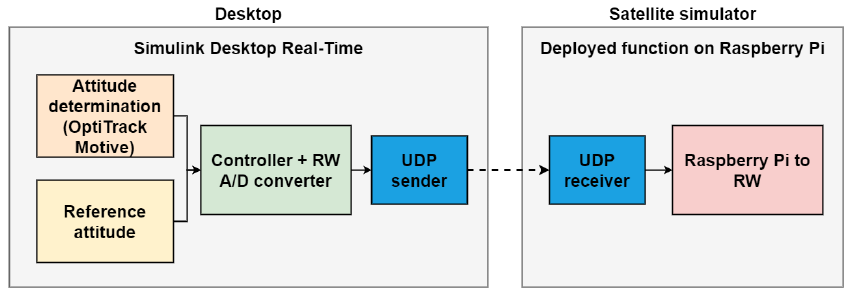
Figure 10. Software architecture block scheme.